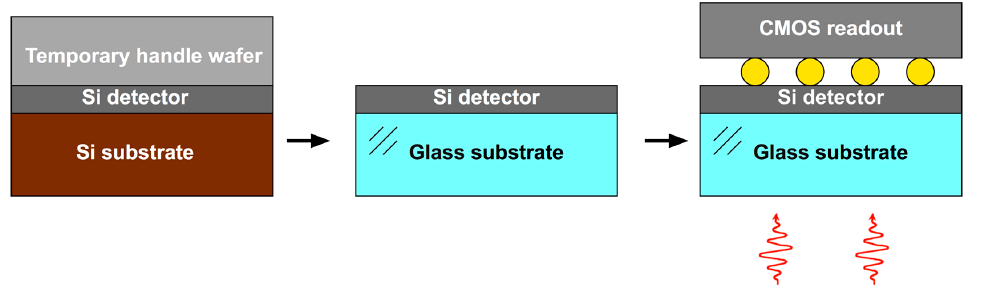
Figure 3. Transfer and bump bonding.